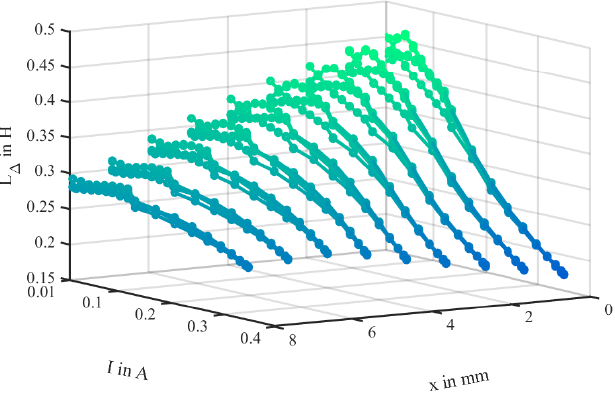
Figure 15. Characteristic of the incremental inductance over different positions and